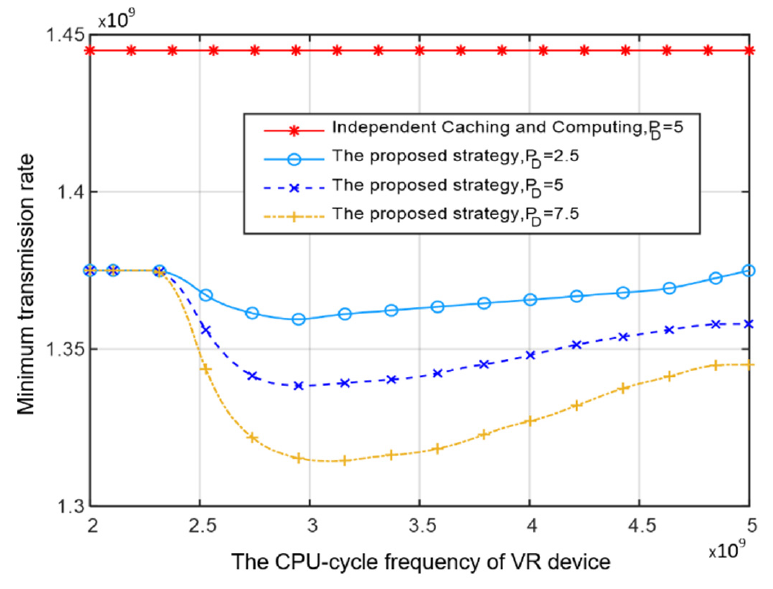
Figure 5. The effect of 𝑓 (cid:3005) on 𝑅 with different 𝑃 (cid:3005) values.